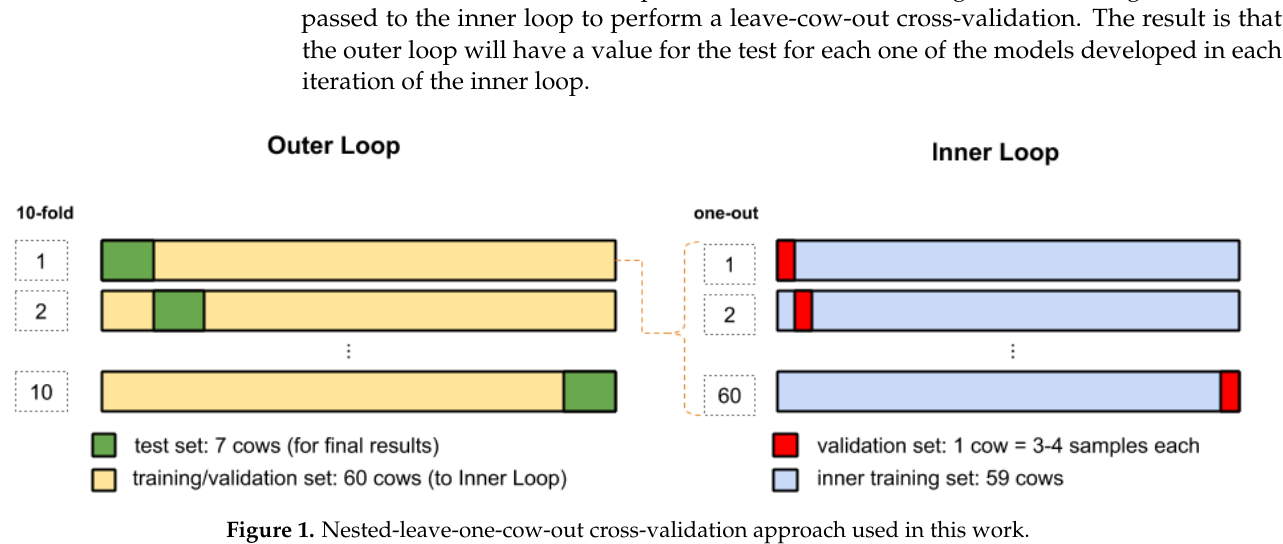
Figure 1. Nested-leave-one-cow-out cross-validation approach used in this work.